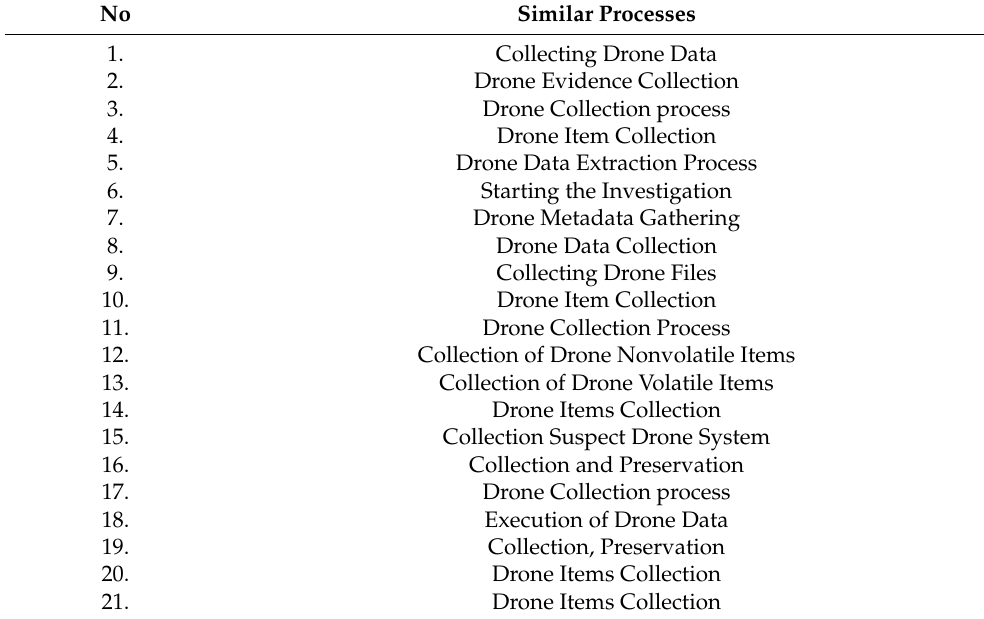
Table 3. Collection and preservation processes.